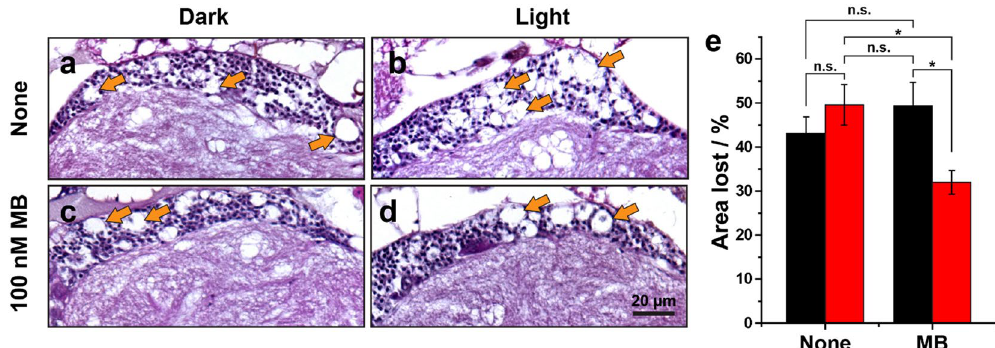
Figure 4. Photo-excited MB reduces the brain vacuolization in adult Drosophila. ( a – d ) Representative haematoxylin and eosin staining of adult head sections in AD model flies ( elav > A β 42 ) with or without 100 nM MB treatment under dark and red LED light conditions. Arrows indicate vacuole phenotypes in aged fly head. Scale bar: 20 μ m. ( e ) Quantification of the vacuole size in adult head sections in AD model flies ( elav > A β 42 ) with or without MB treatment under dark and red LED light conditions. Percentage of the area lost in the cell body areas are shown as the averages s.e.m. (n = 5–7 hemispheres). The error bars represent means s.e.m. Experiments were performed at least three times. * P < 0.05, ** P < 0.01, *** P < 0.001. n.s. not